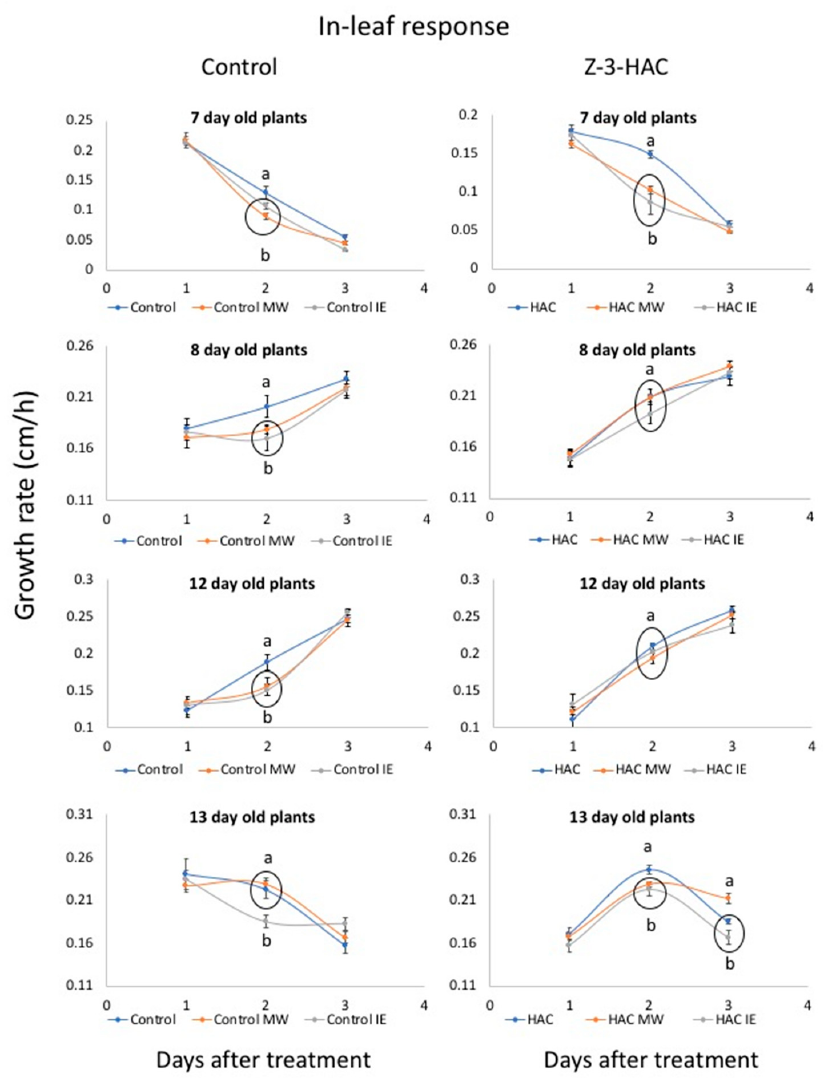
Figure 2. The effects of priming by ( Z )-3-hexen-1-yl acetate (Z-3-HAC) on mechanical wounding (MW) and insect elicitor (IE) induced growth responses in maize ( Zea mays ) seedlings (expressed as growth rate in cm*h − 1 , n ≥ 7). Responses in control maize plants at different ages are shown in the left column and responses of Z-3-HAC-treated plants are shown in the right column. Maize seedlings were first exposed to physiological concentrations of Z-3-HAC (2 μ g l − 1 air volume) for 15 h before being an actively growing leaf was treated with MW or IE (in-leaf treatment). The growth of the treated leaf was measured for 3 days and is expressed as growth rate (cm*h − 1 ). Values are means ± SE and different letters indicate significant differences between the different treatments ( ANOVA , P < 0.05). Circled time points indicate no significant differences between treatments on day 2. Day 1 and Day 3 growth rates show no significant differences between treatments, with only 13-day-old Z-3-HAC-treated seedlings showing different growth rates on day 3 (circled).